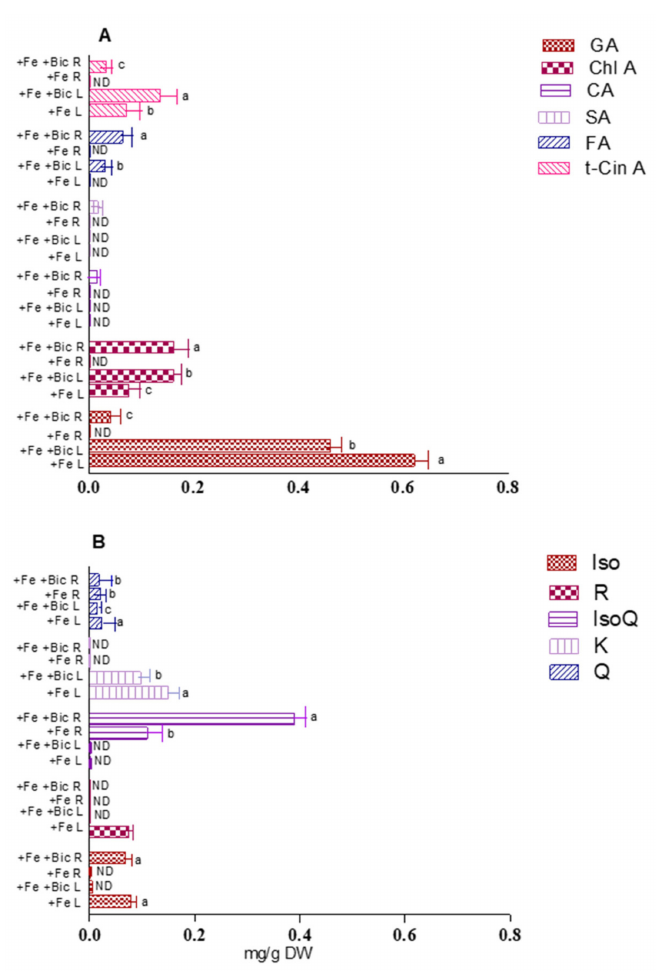
Figure 5. Contents of individual phenolic acids ( A ) and flavonoids ( B ) (mg/g DW) in leaves (L) and roots (R) of fennel plants grown in the presence of Fe (+Fe) or in the presence of Fe plus bicarbonate (+Fe +Bic). GA, gallic acid; Chl A, chlorogenic acid; CA, caffeic acid; SA, syringic acid; FA, ferulic acid; t-Cin A, trans -hydroxycinnamic acid; Iso, isorhamnetin; R: rutin, IsoQ: isoquercetin; K, kaempferol; Q, quercetin; ND, non-detected. Data represent the mean ± standard deviation of three independent assays. Values with different superscripts are significantly different at p <